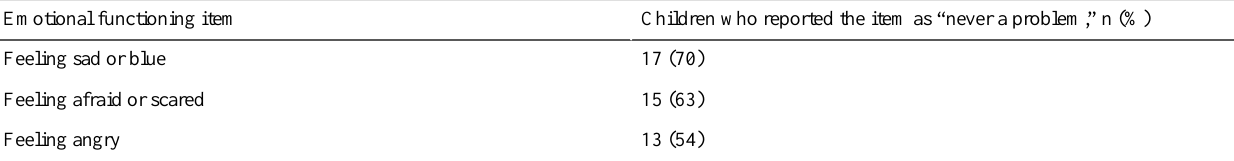
Table 4. Children’s reporting on emotional functioning using the Pediatric Quality of Life Inventory (n=24).